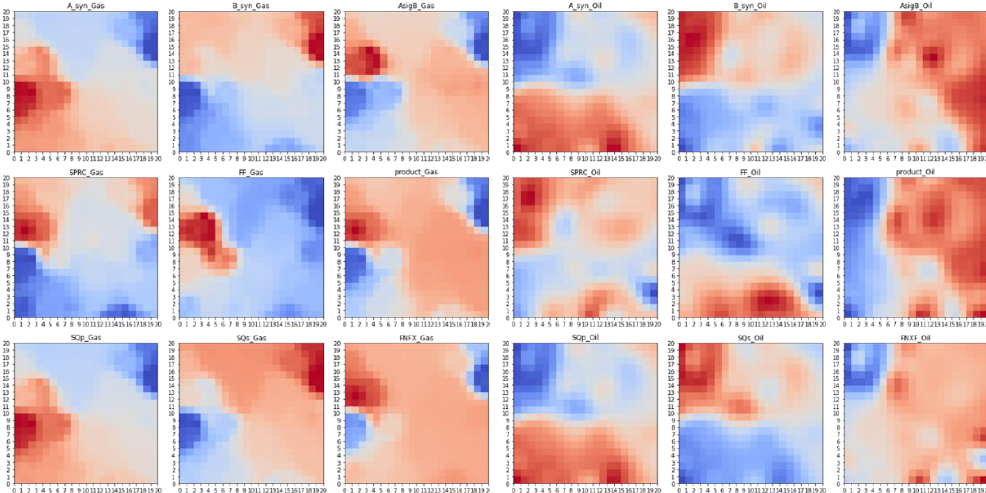
Figure 4. Feature map generated by SOM in oil & gas situation dataset.